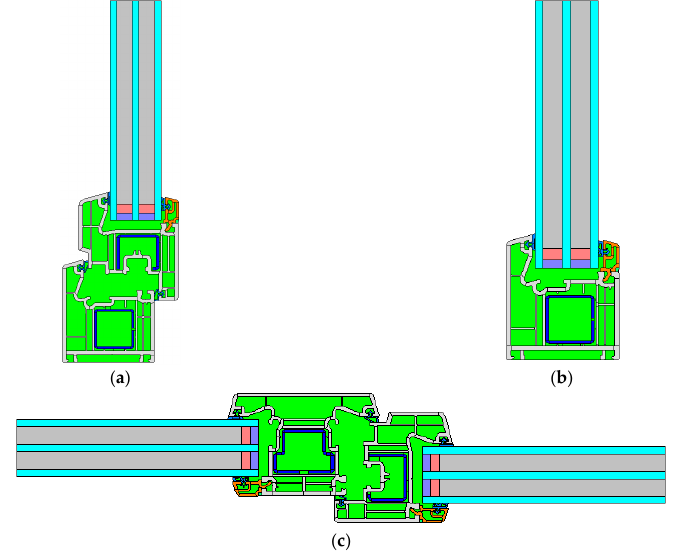
Figure 6. Cross-sections of a simulation model: ( a ) sill of a tilt and turn window; ( b ) sill of a fix window; and ( c ) meeting rail.